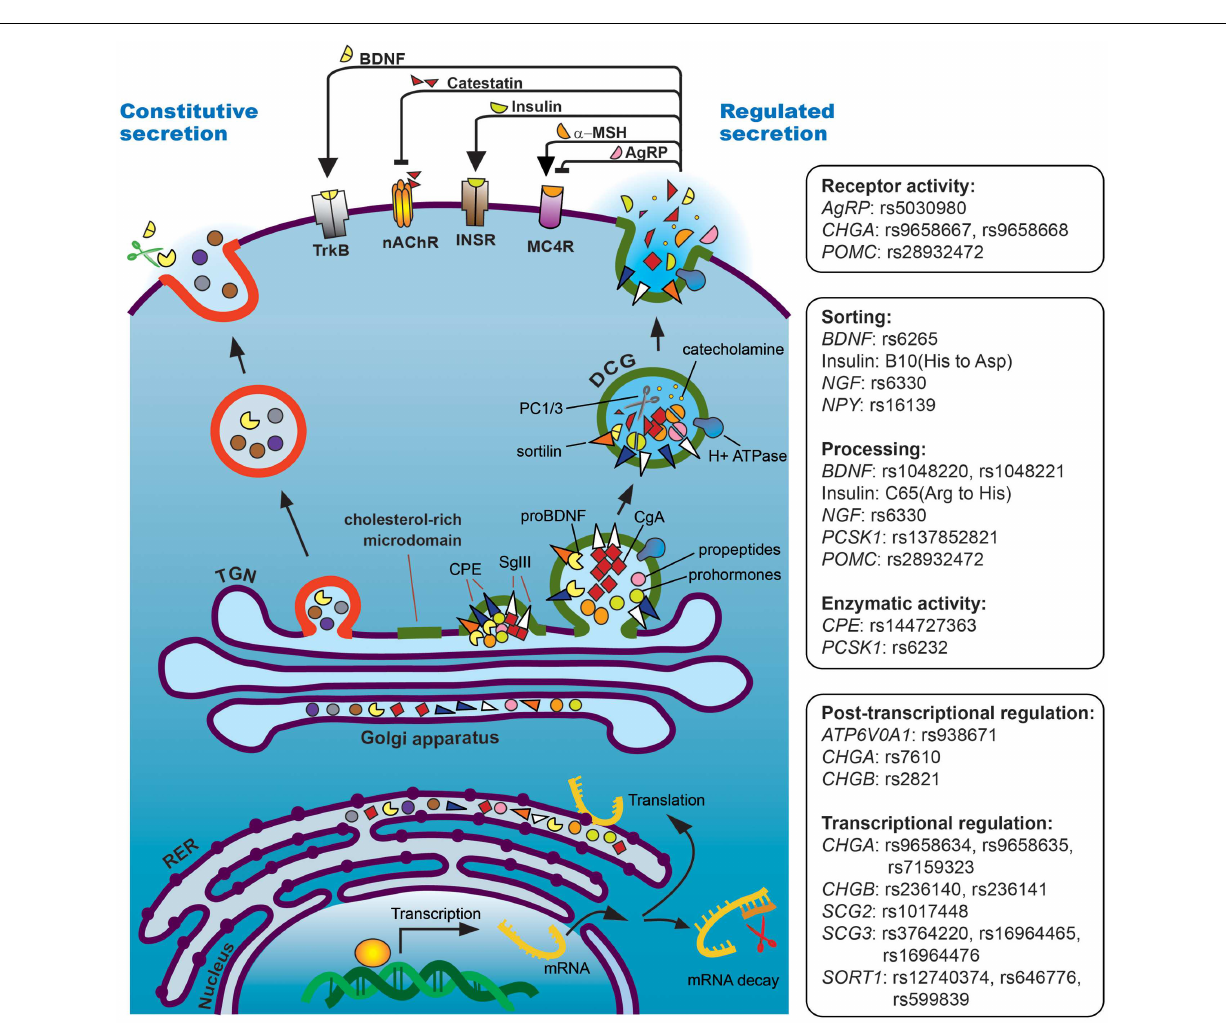
FIGURE 1 | Regulated secretory pathway of a model neuroendocrine cell . Single nucleotide polymorphisms (SNPs) can affect granule biogenesis and release through these mechanisms: (1) SNPs in the promoter or 3 (cid:48) UTR of granule-associated genes modulate gene expression levels, resulting in altered granule biogenesis, (2) SNPs in the pro-domain of peptides or hormones block their processing and/or sorting into the regulated pathway, (3)